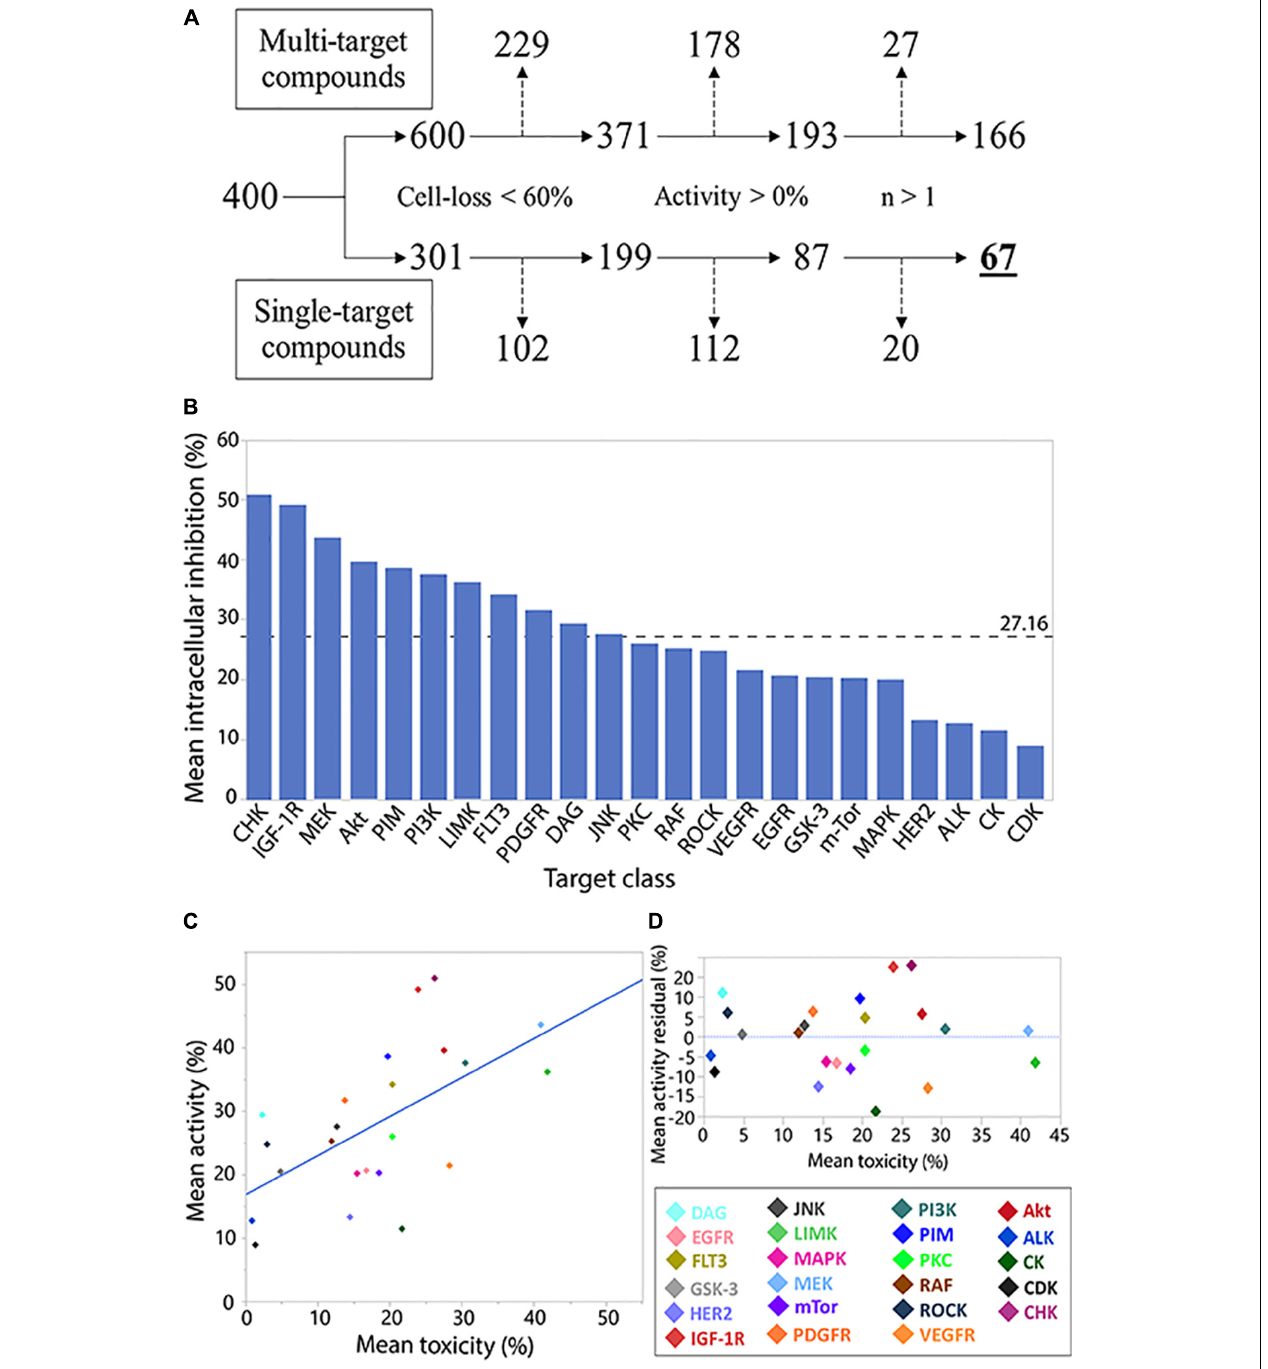
FIGURE 2 | Analysis of compound target class/family. Flowchart analysis of the logic steps taken to ensure activity characterization (measuring normalized intracellular bacterial growth inhibition) of target families was gathered from non-pleiotropic compounds (single-target compounds) and were not skewed by THP-1 cell-loss, exhibit anti- M.tb activity, and were represented by more than 1 compound in the library. Branch shifts from compound numbers (400) to compound target numbers (600/301). Excluded targets from each step marked by dashed arrows (A) . Compound family charted by mean inhibitory activity. Weighted average marked by dashed line (B) . Regression analysis of family toxicity (cell-loss) on activity resulted in linear regression with RMSE = 9.66% ( R 2 = 0.36) (C) . Analysis of residual activity by target family classes. Positive or negative residual values represent higher or lower activity, respectively, than can be explained by toxicity effects against THP-1 cells (D)